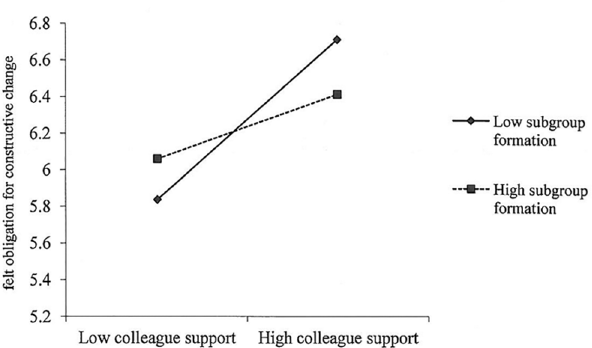
Fig 3. Moderating effect. Subgroup formation moderates the relationship between colleague support and felt obligation for constructive change.